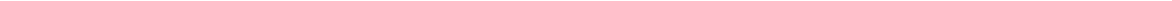
Fig. 2 CAFs remodel the BM and stimulate cancer cell invasion. a Quanti fi cation of cancer cell invasion through mesenteric BM in the physical presence of CAFs (CAF PP) or their secreted molecules (CAF SM) from patients 1 and 3. Data are represented as box and whiskers (10 – 90 percentile) plus